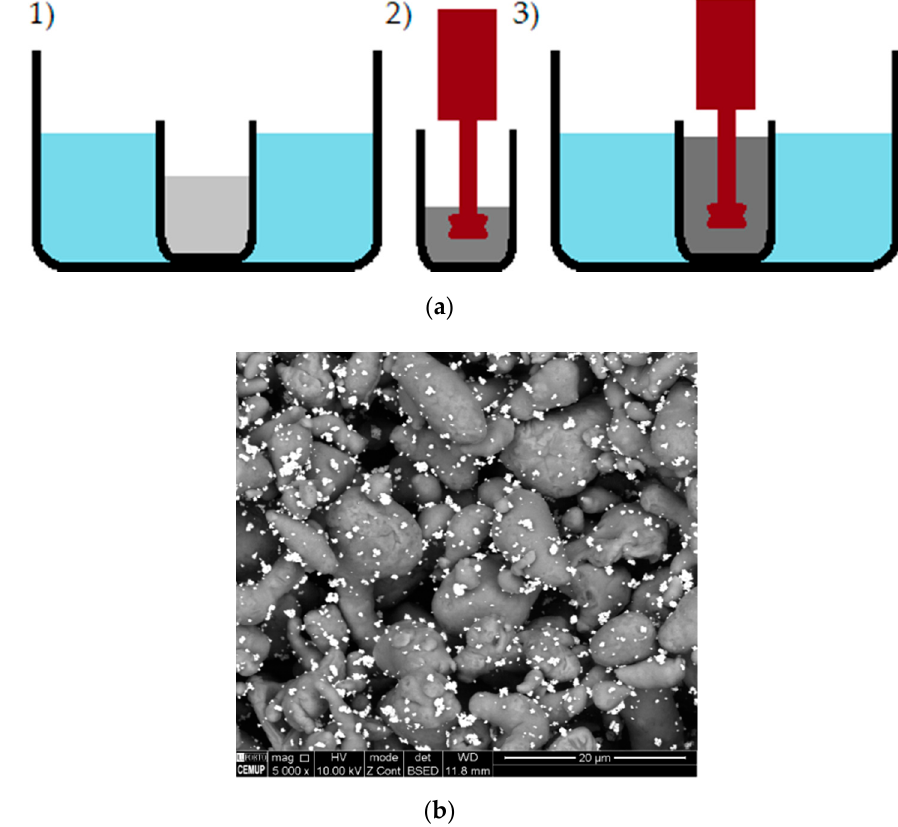
Table 1. Sintering conditions of non-reinforced Al and of Al-1 WC vol.% composite.